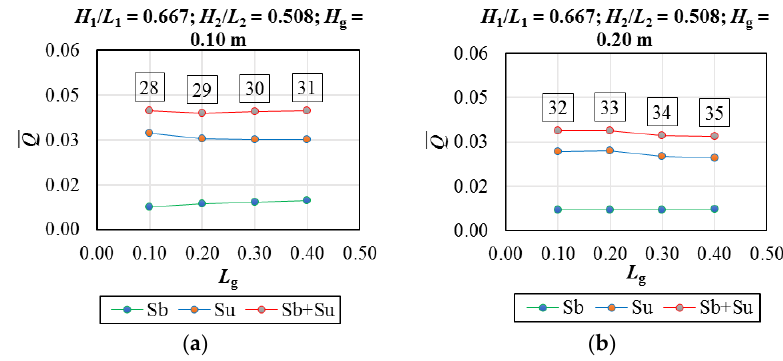
Figure 21. Behavior of Q ̅ × L g for: ( a ) cases 28, 29, 30 and 31 and ( b ) 32, 33, 34 and 35.